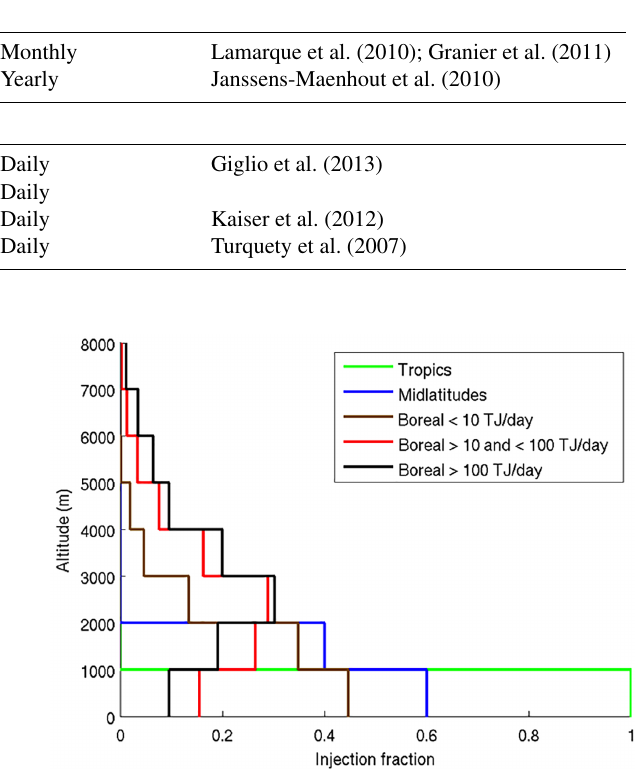
Figure 2. Injection profiles used for biomass burning emissions for different regions (tropics, midlatitudes, boreal) in the MIXED